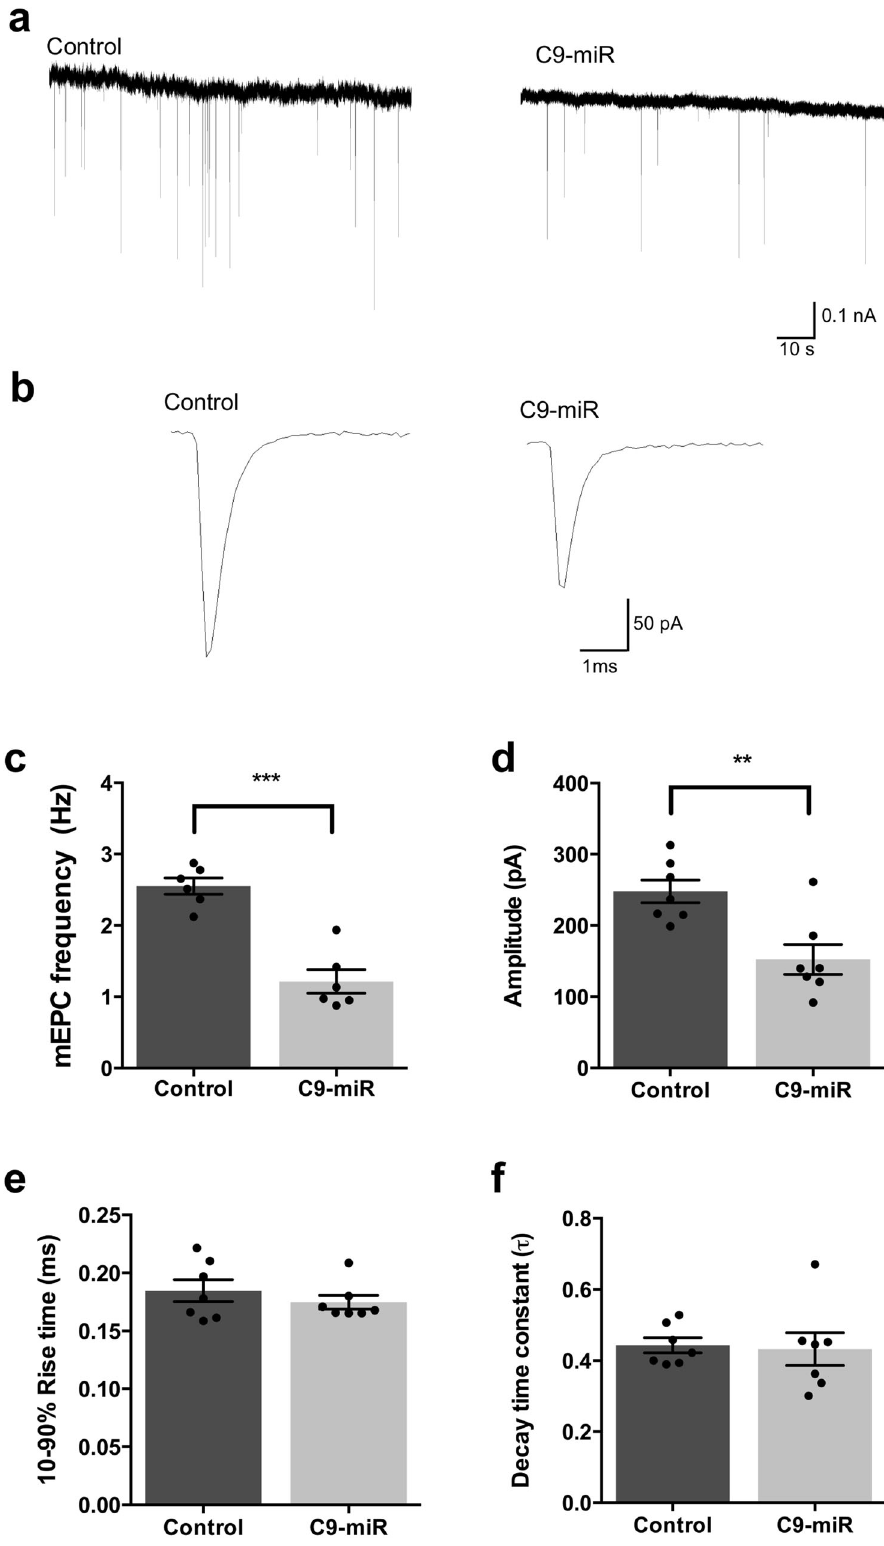
Fig. 3 C9-miR zebra fi sh exhibited attenuated miniature endplate currents (mEPCs) at NMJs. a Recordings of mEPCs, which result from spontaneous release of a quantum, were recorded in 6 dpf control and C9-miR fi sh ( n = 6). b Representative mEPCs. Animals with reduced C9orf72 (C9-miR) displayed mEPCs with reduced frequency ( c ) ( n = 6 – 7; *** p < 0.0001; Student ’ s t test) and amplitude ( d ) ( n = 7; ** p < 0.001; Student ’ s t test). Rise time ( e ) ( n = 7; p = 0.3947; Student ’ s t test) and decay time ( f ) constant kinetics of mEPC ( n = 7; p = 0.8385; Student ’ s t test) were not found to be signi fi cantly different between controls and C9-miR. Data are presented as mean ± SEM. n represents the number of fi